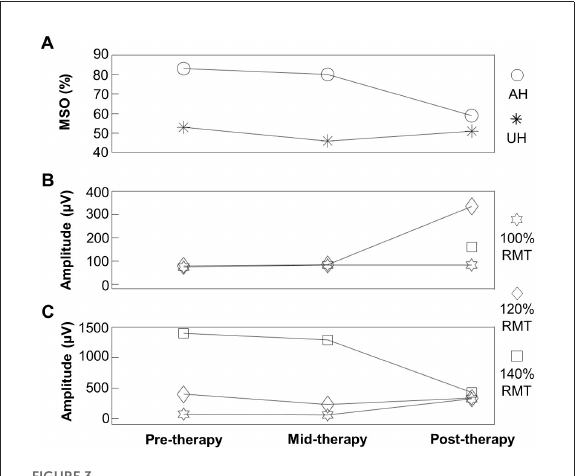
FIGURE3 (A) Resting-state motor threshold (RMT) for the affected (AH) and unaffected (UH) hemispheres. (B) Motor evoked potential amplitude in the affected hemisphere (AH) at 100%, 120%, and 140% of the RMT at pre-therapy, mid-therapy, and post-therapy. (C) Motor evoked potential amplitude in the unaffected hemisphere (UH) at 100, 120, and 140% of the RMT